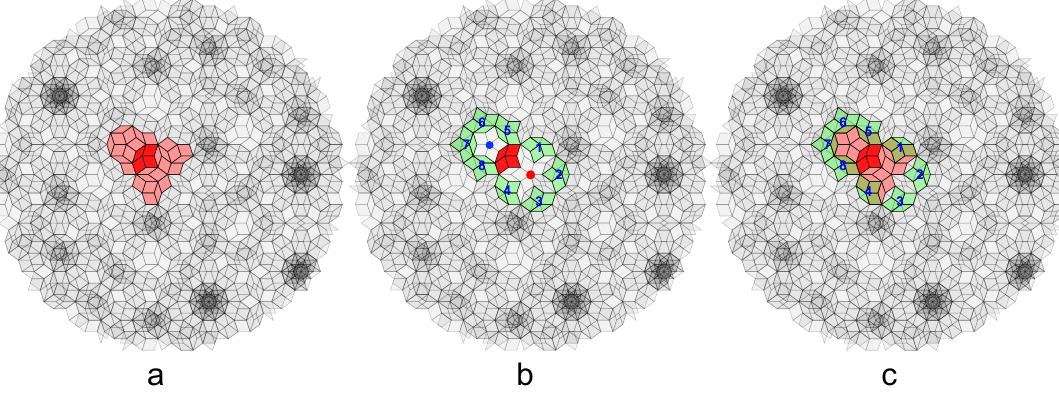
Figure 3. Game of life variants in Penrose tiling. ( a ) The living vertex patch of the K type vertex is colored red and the pink tiles surrounding it represent its local empire. These tiles act as supporting tiles that always coexist with the chosen vertex patch. The gray tiles form the possibility space—tiles that could potentially coexist with the vertex. ( b ) The eight vertex patches in green are the neighbors of the dominant vertex patch that must live in the possibility space. ( c ) Overlaying together the living vertex patch, its supporting tiles, its neighbors and its possibility